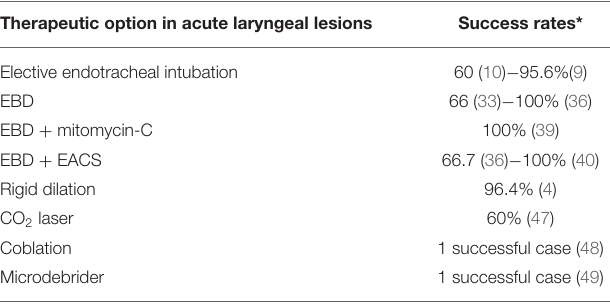
TABLE 4 | Comparison of therapeutic approaches success rates. Therapeutic option in acute laryngeal